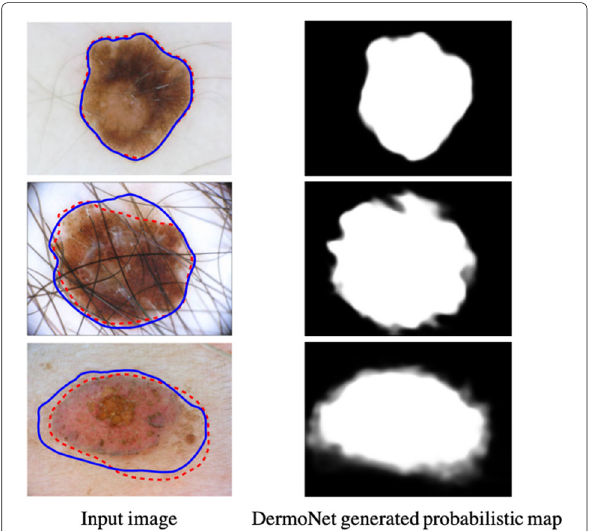
Fig. 4 Sample segmentation results of ISBI 2016 challenging images. Ground truth contours and our detected contours are marked in red and blue,